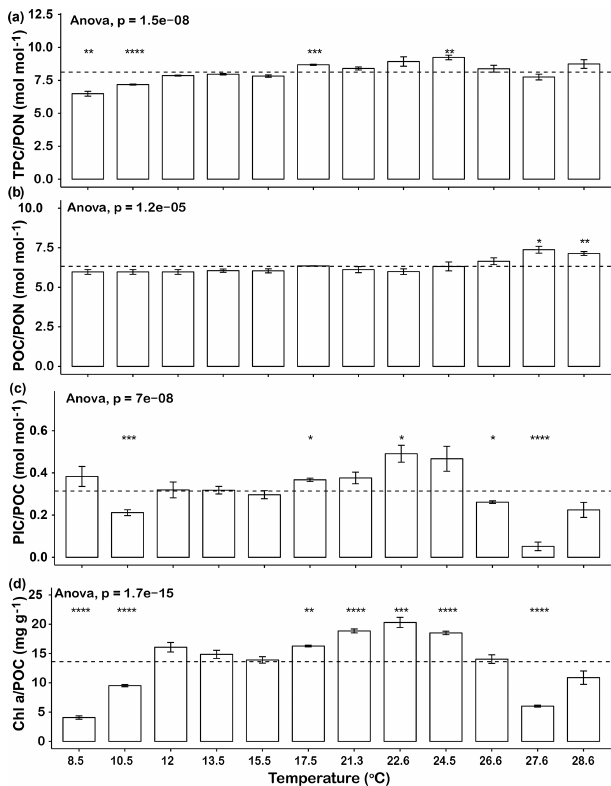
Figure 2. Changes in Emiliania huxleyi TPC / PON ratios (a) , POC / PON ratios (b) , PIC / POC ratios (c) and Ch a / POC ra- tios (d) across a temperature range from 8.5 to 28.6 ◦ C. Dashed lines represent the average ratios for the entire temperature range. Bars represent means, and error bars are the standard deviations of three replicates at each temperature. Asterisks ( ∗ ) represent the sig- nificant difference ( p< 0 . 05) between average ratios and the ratio at each